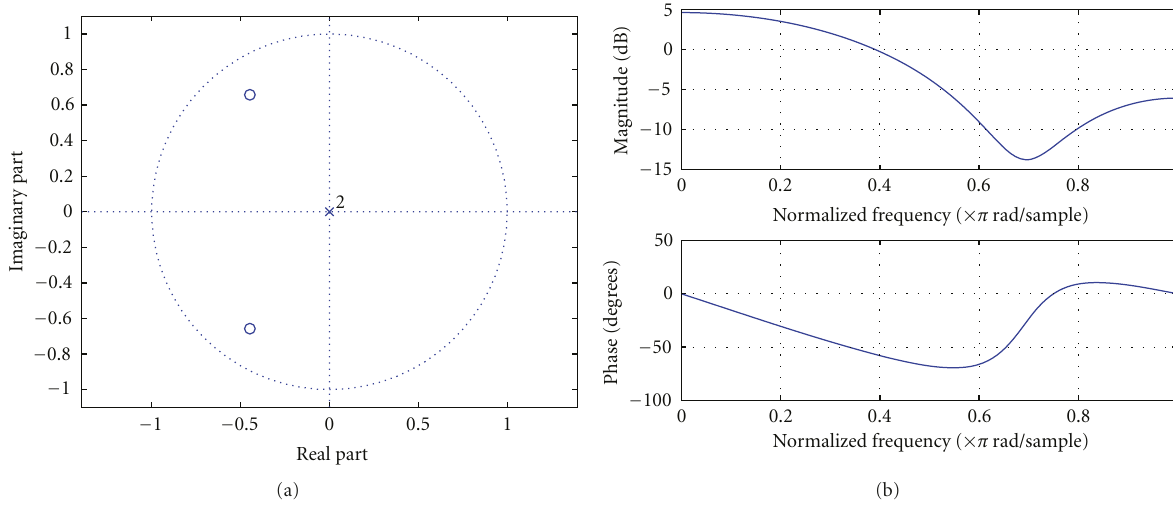
Figure 3: (a) Zeros of H ( z ); (b) amplitude and phase responses of the